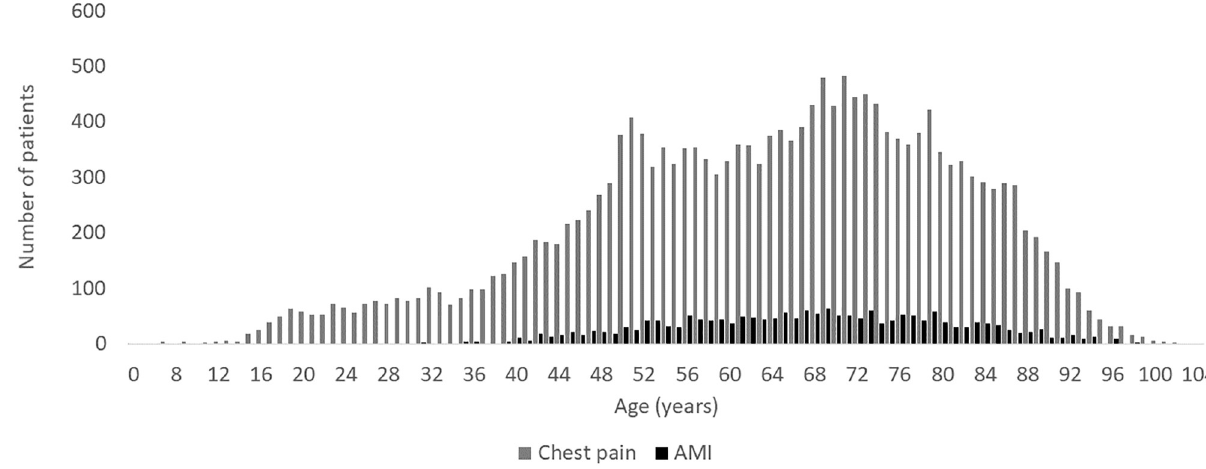
Fig 2. Age distribution among all patients with chest pain according to Danish Index (grey) and patients subsequently diagnosed with AMI (black), in the years 2012–2018 (excl. 2015).